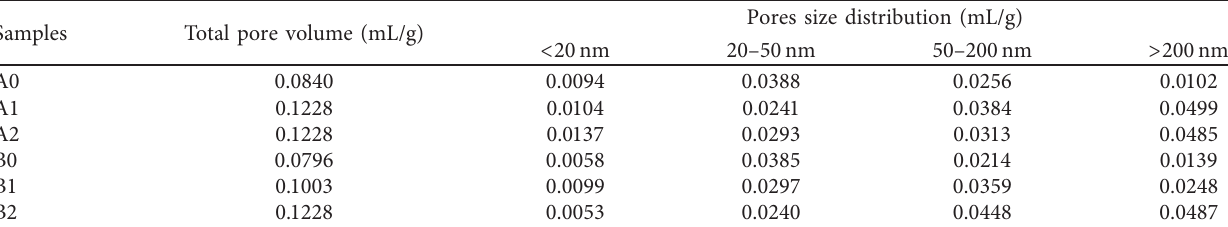
Figure 11: Effects of SAP on pore structure (differential pore size distribution) in the hardened cement pastes at the age of 56 days determined by MIP. (a) Hardened pastes without FA; (b) hardened pastes with Table 3: Results of pore structure in hardened pastes.